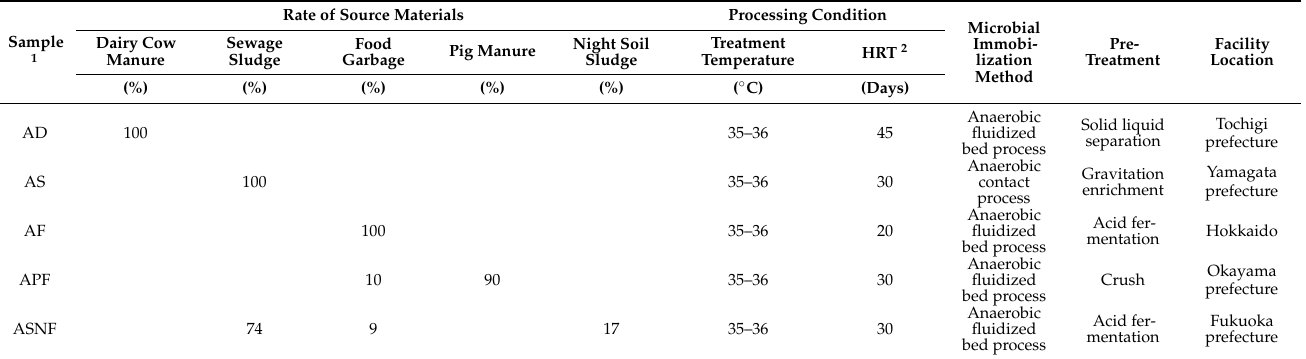
Table 1. Source material composition, processing conditions, and facility location for five anaerobi- cally digested slurries